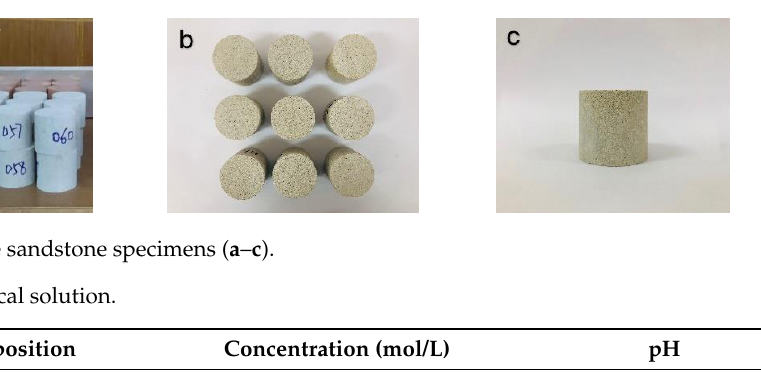
Table 1. Chemical solution.